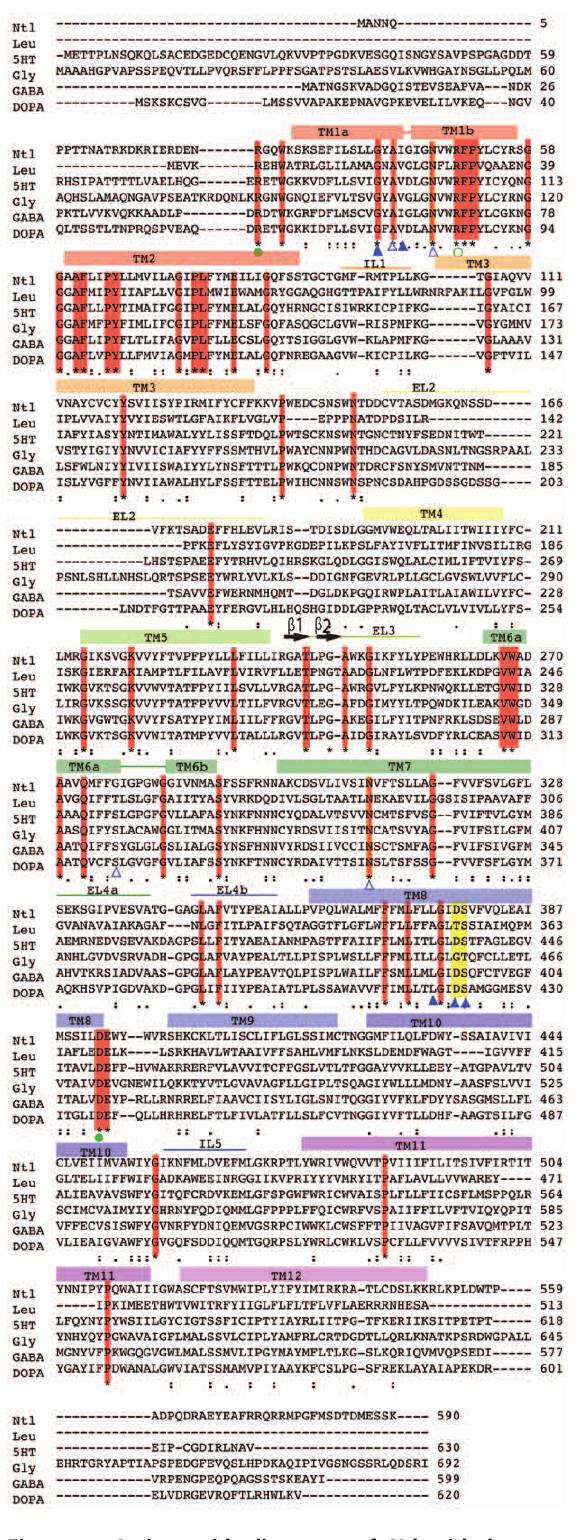
Figure 1. Amino acid alignment of Ntl with human and A.aeolicus SLC6 transporters. Amino acid sequence alignment of Drosophila melanogaster Ntl (Ntl; NP_609135.1) with A.aeolicus Leu T Aa (Leu; NP_214423), human homologues for Serotonin (5HT;P31645), Glycine (Gly, I57956), GABA (GABA; P30531), Dopamine (DOPA; Q01959) using Clustal W alignment [http://www.ebi.ac.uk/Tools/clustalw2/index. html]. Strictly conserved residues are highlighted in red; a coils and